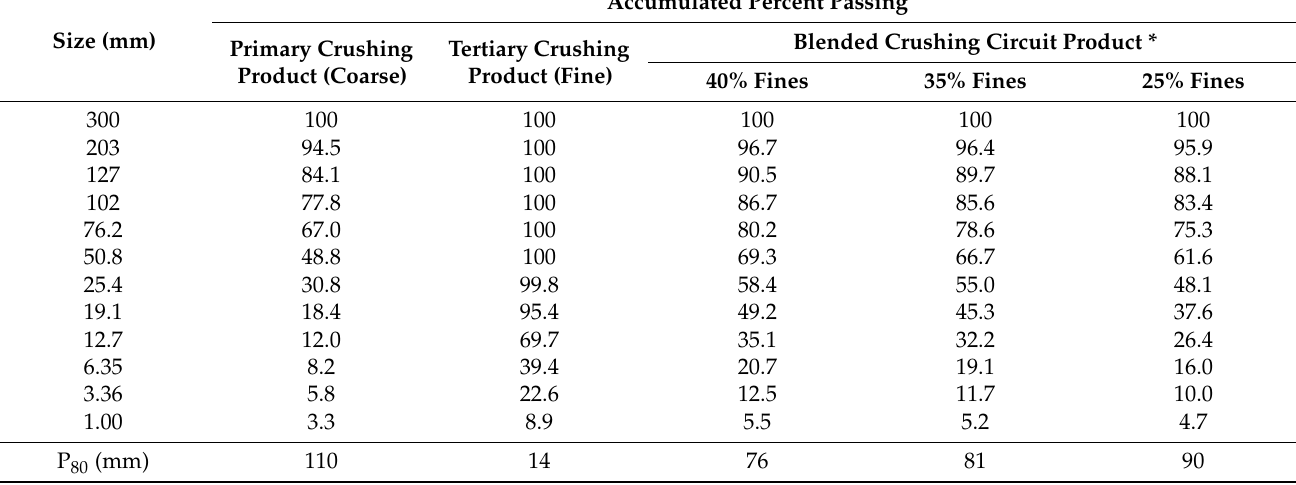
Table 3. Cristalino crushing circuit size